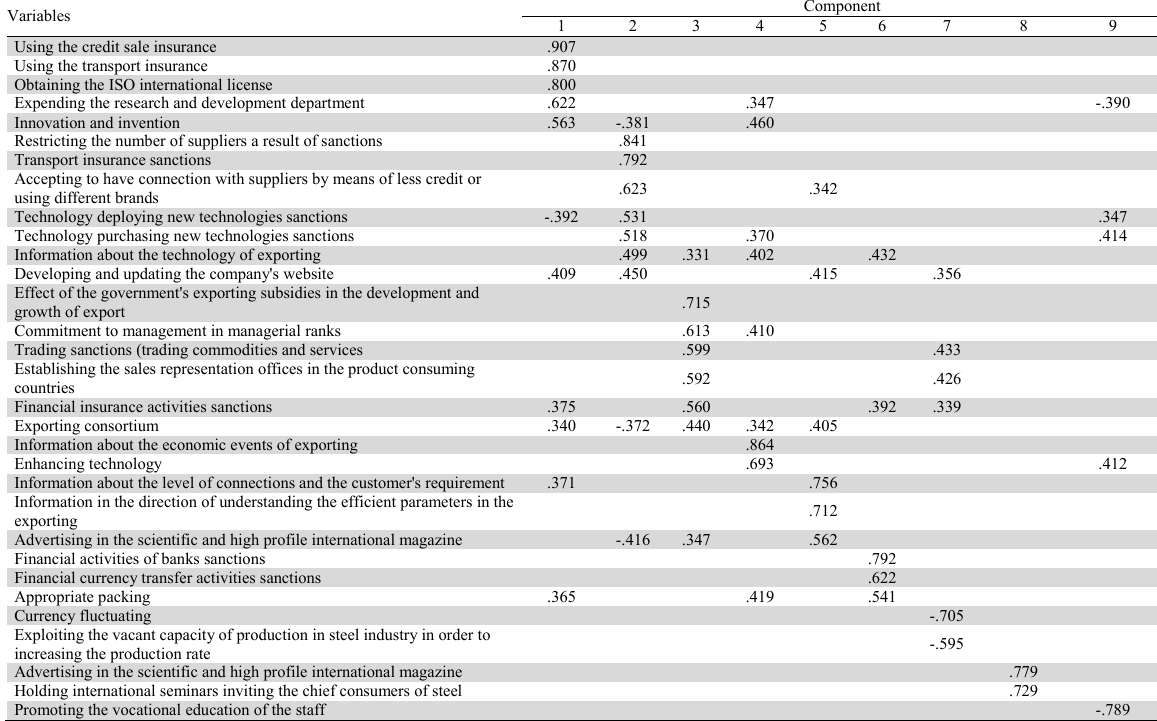
The results of PCA after Varimax rotation for firm performance Variables Establishing and implementing the rewarding